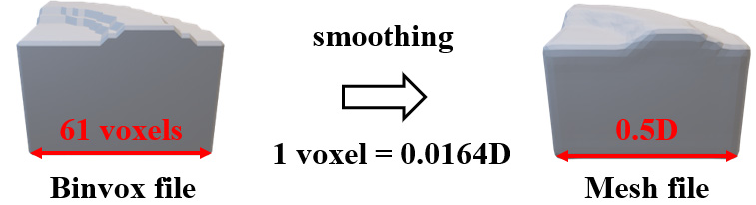
Figure A2. Post-processing procedure to real scale.